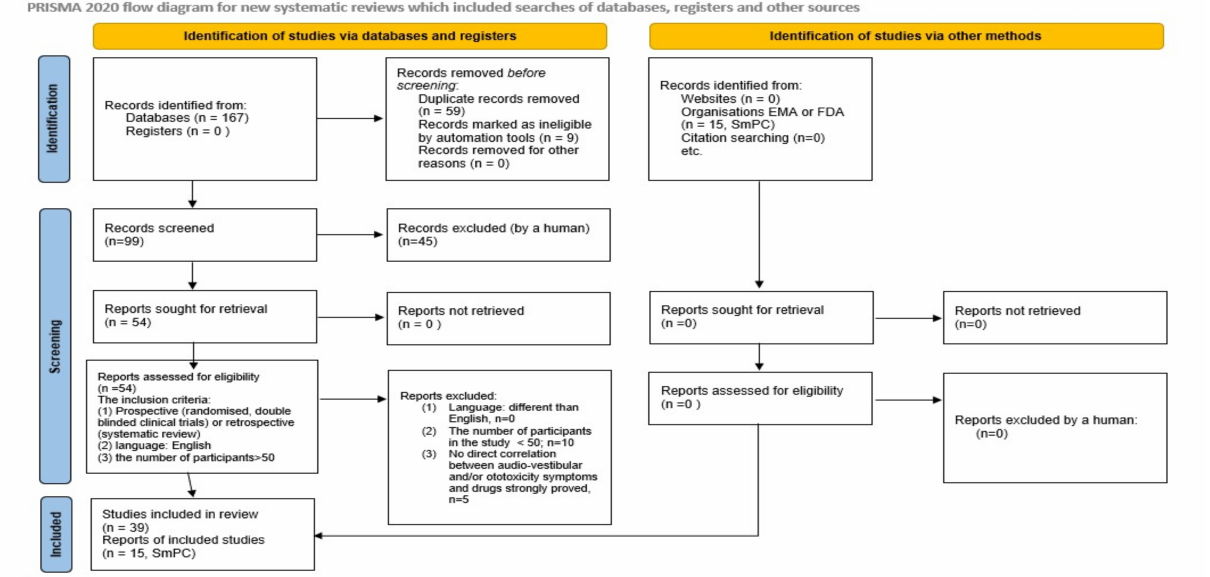
Figure 1. The combinations of words used for searching articles.